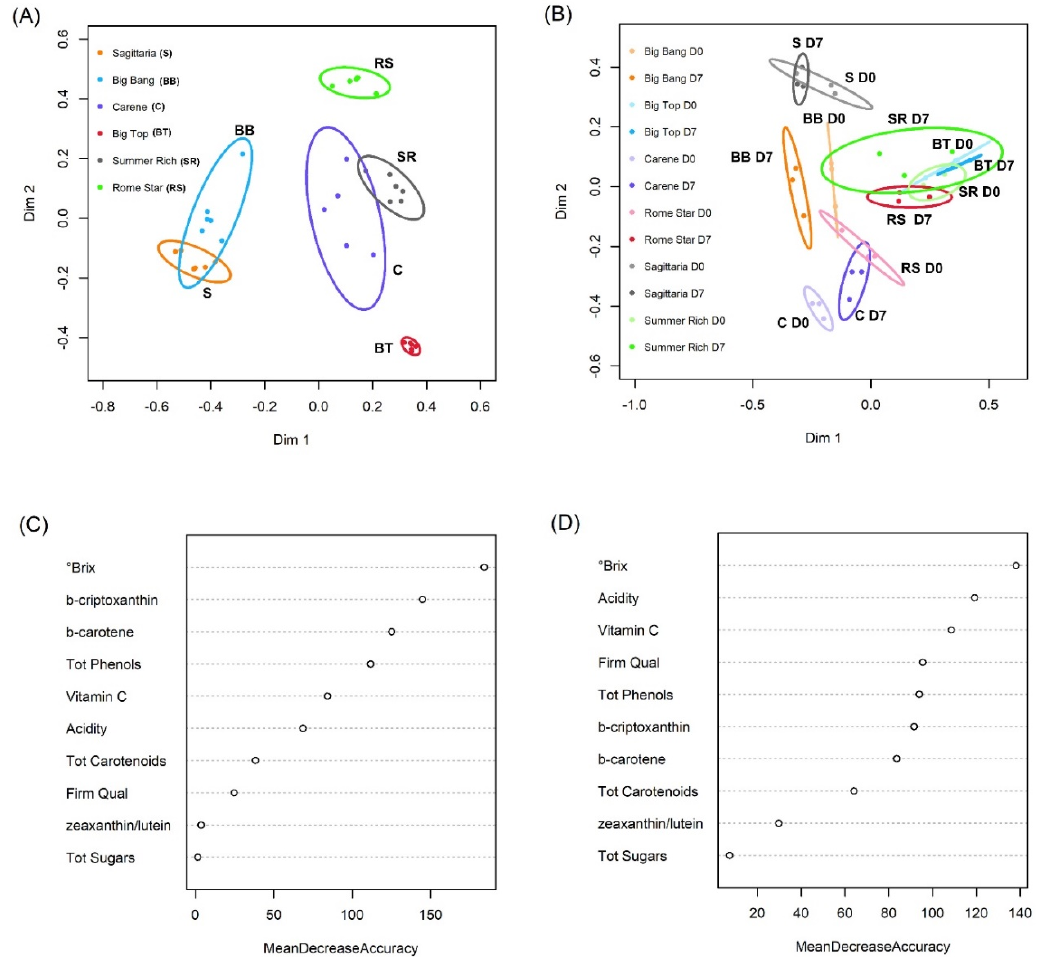
Figure 1. Results from Random Forest cultivar classification based on intrinsic quality characters. ( A ) Multi-dimensional scaling (MDS) plot based on the proximity matrix when D0 and D7 time points are analysed together. ( B ) MDS plot based on the proximity matrix with D0 and D7 time points separated. Each ellipse represents the 95% confidence interval. ( C ) Mean Decrease Accuracy analysis for the Random Forest in panel A. ( D ) Mean Decrease Accuracy analysis for the random forest in panel B. Features are ranked by their contributions to classification